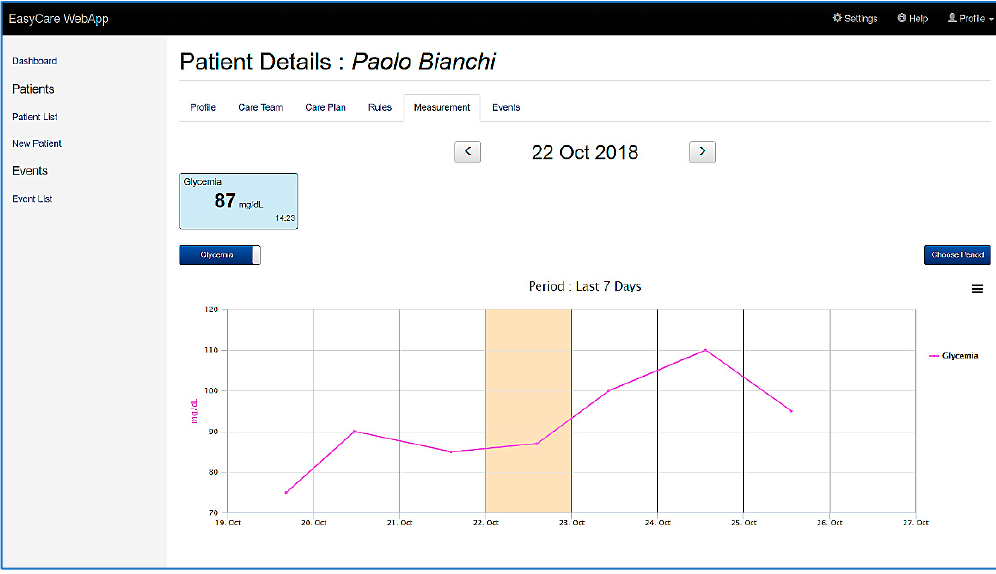
Figure 8. Patient-specific measurement results chart.